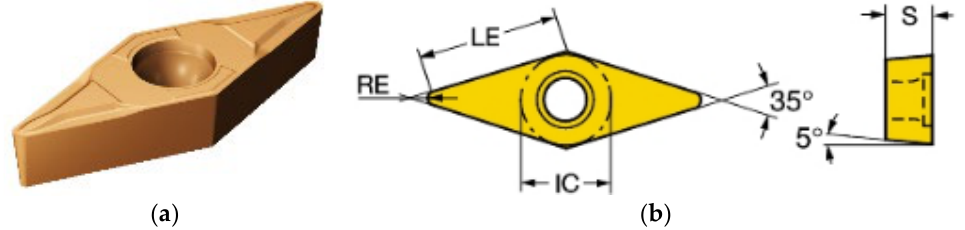
Figure 1. ( a ) Schematic drawings of ( a ) the Sandvik Coromant mod. CoroTurn ® 107 cutting tool and ( b ) the main geometrical features [28].